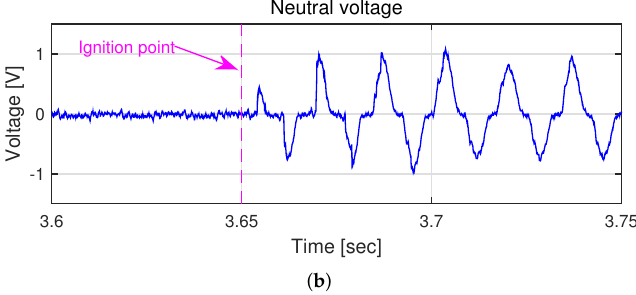
Figure 3. Phase voltage and neutral voltage in experiments. ( a ) Phase voltage. ( b ) Neutral voltage.